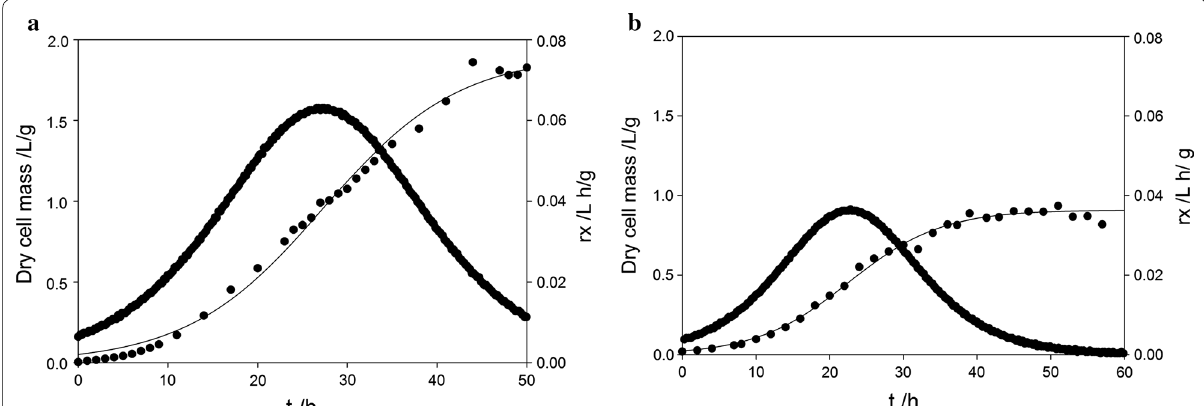
Fig. 2 Dry cell mass building rate of a BS115 and b PsJN. The dry cell mass data points were fitted with a three parameter sigmoid function with an R 2 of 0.99. This function was used to calculate the slope (ΔDCM/Δt)